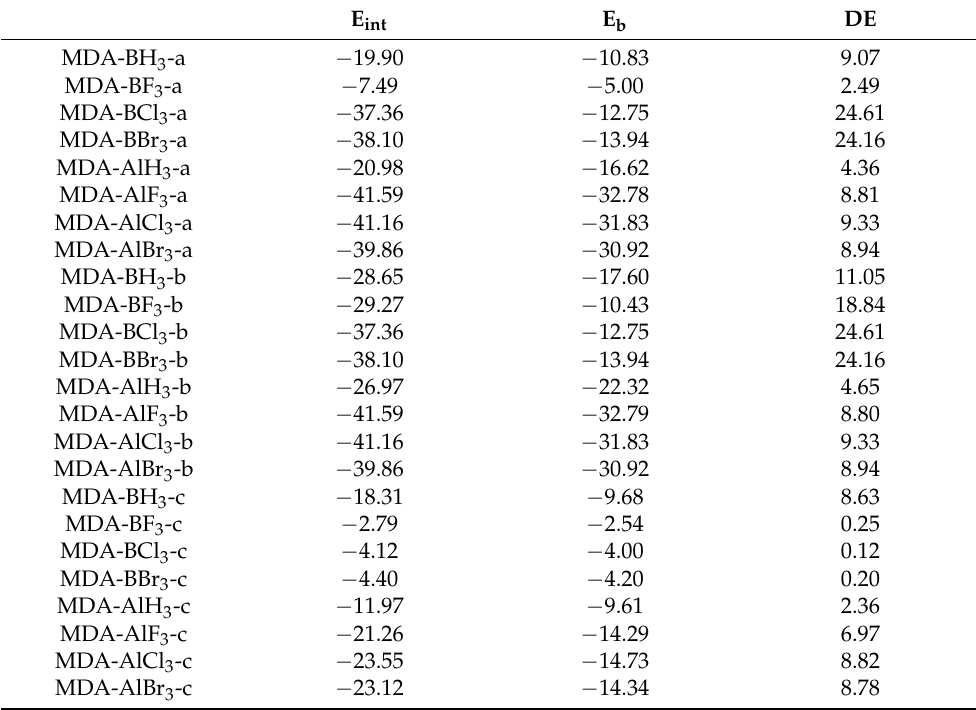
Table 1. Interaction energy (E int ), binding energy (E b ), and deformation energy (DE) of triel bond in the complexes, all in kcal/mol.